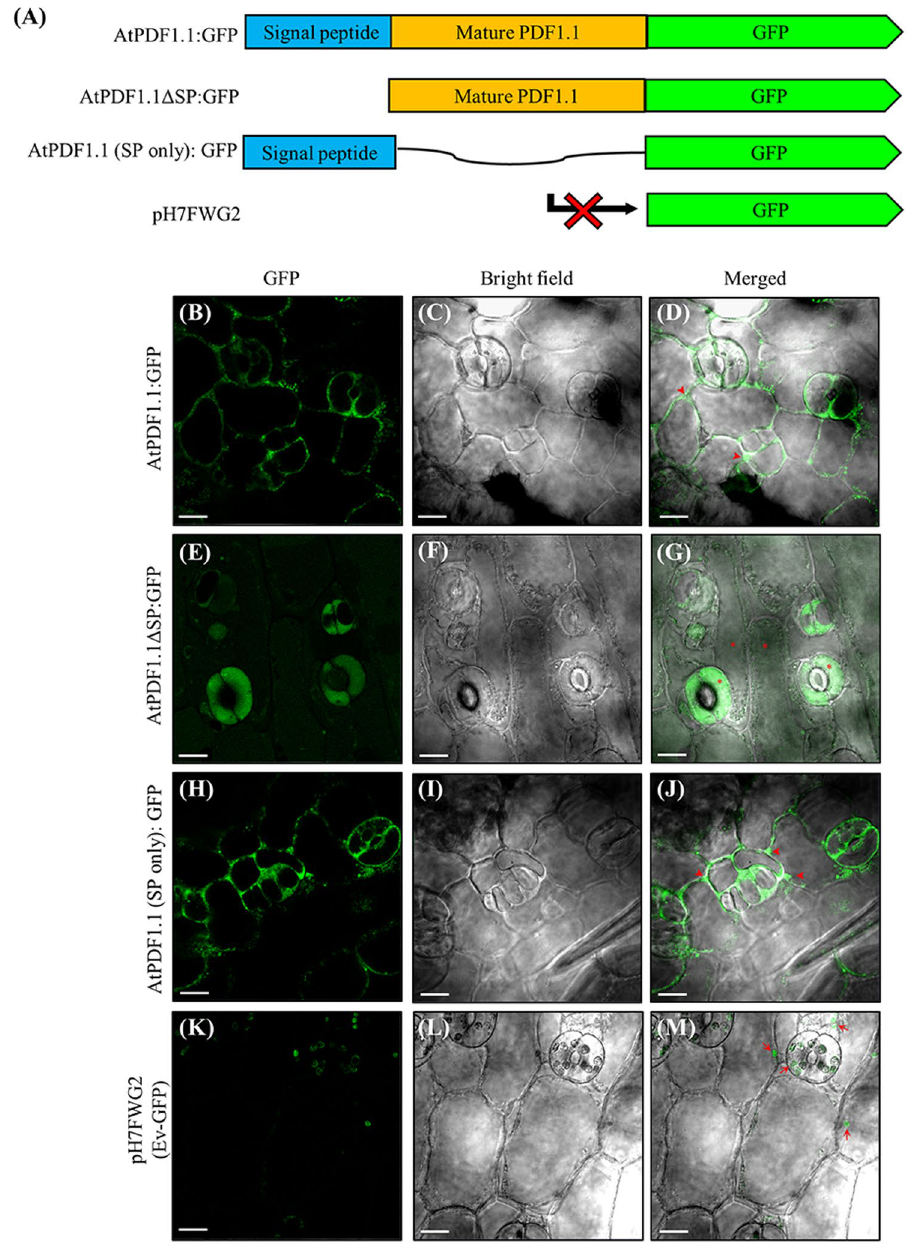
Figure 2. AtPDF1.1 fusion proteins are localized and accumulated in the apoplast. ( A ) Schematic diagram of the AtPDF1.1:GFP (green fluorescent protein), AtPDF1.1 Δ SP:GFP and AtPDF1.1(SP only):GFP fusion constructs. The leaf epidermis of AtPDF1 . 1:GFP ( B – D ), AtPDF1 . 1 Δ SP:GFP ( E – G ), AtPDF1 . 1 ( SP only ) :GFP ( H – J ) and Ev-GFP transgenic Arabidopsis thaliana plants ( K – M ) were subjected to confocal microscopy to determine the subcellular localization of AtPDF1.1 fusion proteins. Left panel, GFP fluorescence; middle panel, bright field images; right panel, merged images. Each line was repeated at least three times with similar results. Asterisks ( * ) denote GFP signals detected in the cytosol (asterisks), arrowheads denote GFP signals detected in the apoplastic space and arrows denote the chlorophyll fluorescence. Bars, 10 μ